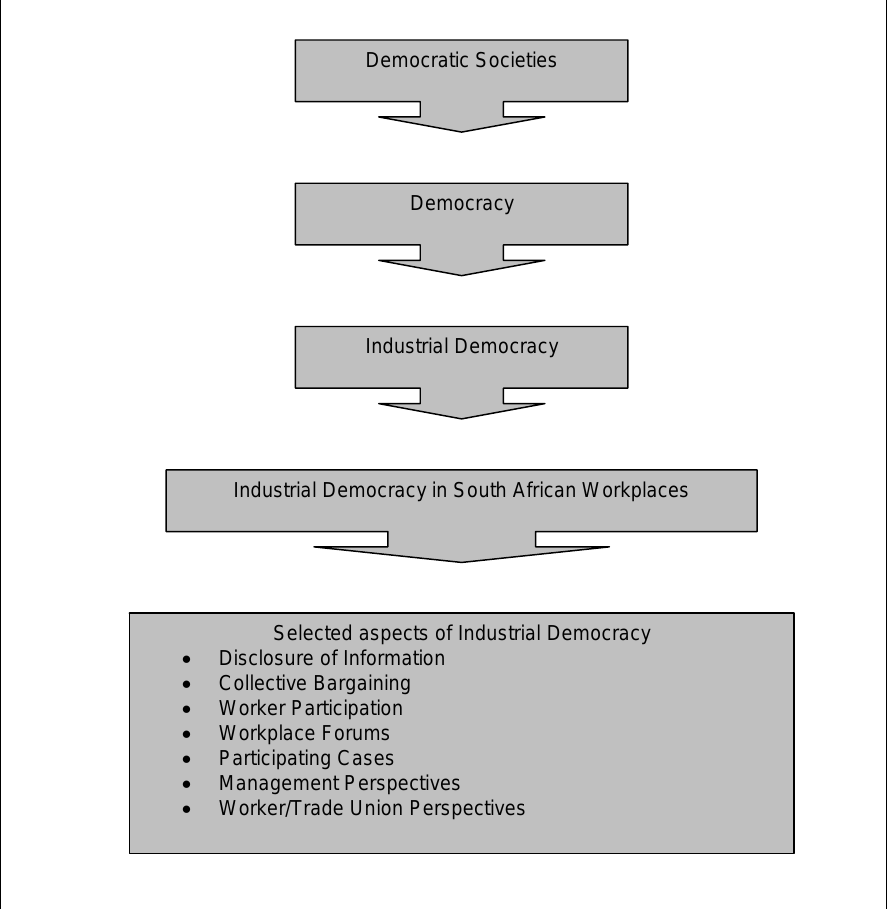
Figure 1:Conceptual